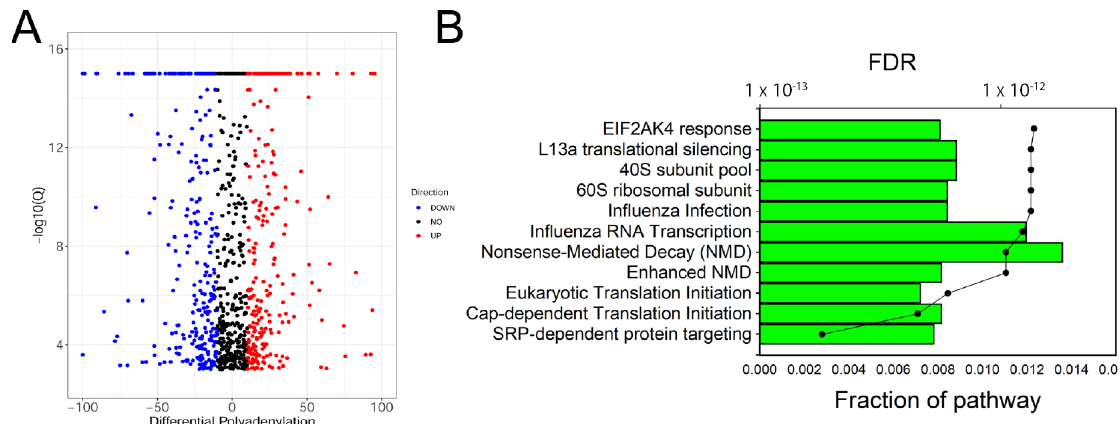
Figure 3. Alternative polyadenylation analysis. ( A ) Scatter plot of differentially polyadenylated transcripts in response to RSV infection. X axis: differential polyadenylation utilization (DPAU). DPAU refers to the fraction of transcripts utilizing the distal polyadenylation site. A positive-valued DPAU indicates enhanced distal site polyadenylation in RSV-infected cells, while a negative value indicates distal site utilization in uninfected cells. Y axis: − log10 ( Q -value) of significance of change. ( B ) Pathway enrichment of genes undergoing DPAU. Shown are the top 10 gene pathways (Reactome.org) for a fraction of the pathway represented (boxes) in the query data and the false discovery rate (FDR, circles) of each